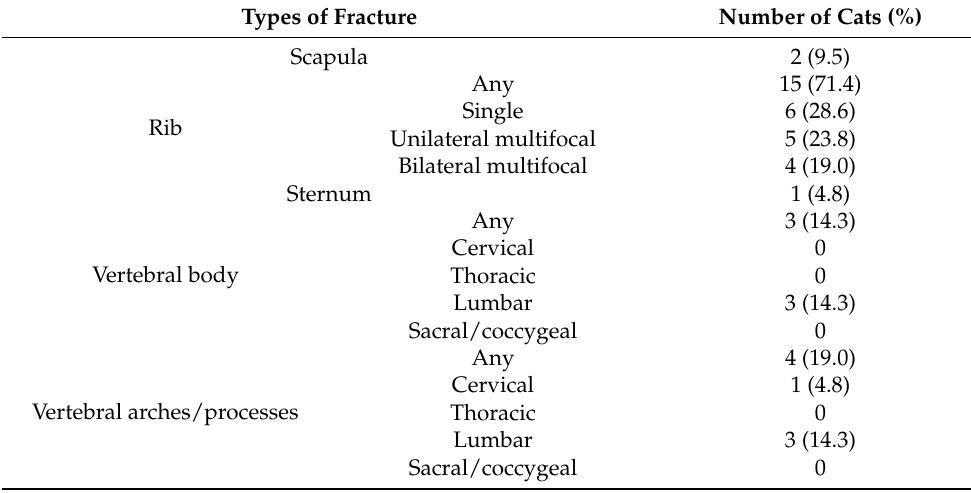
Table 2. Number and percentage of fractures in 21